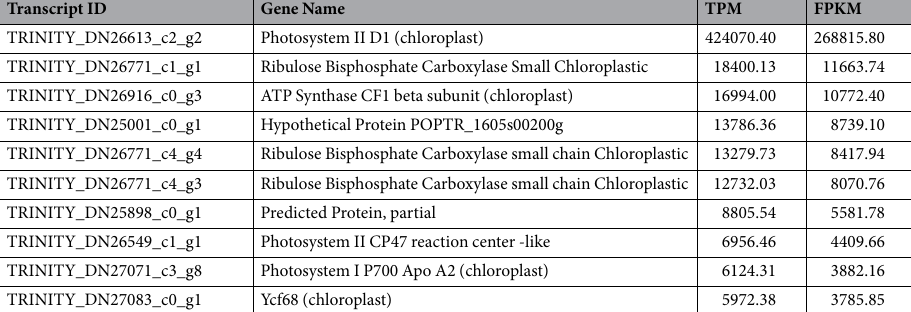
Table 5. Top 10 most abundant genes from leaf tissue of Solanum trilobatum